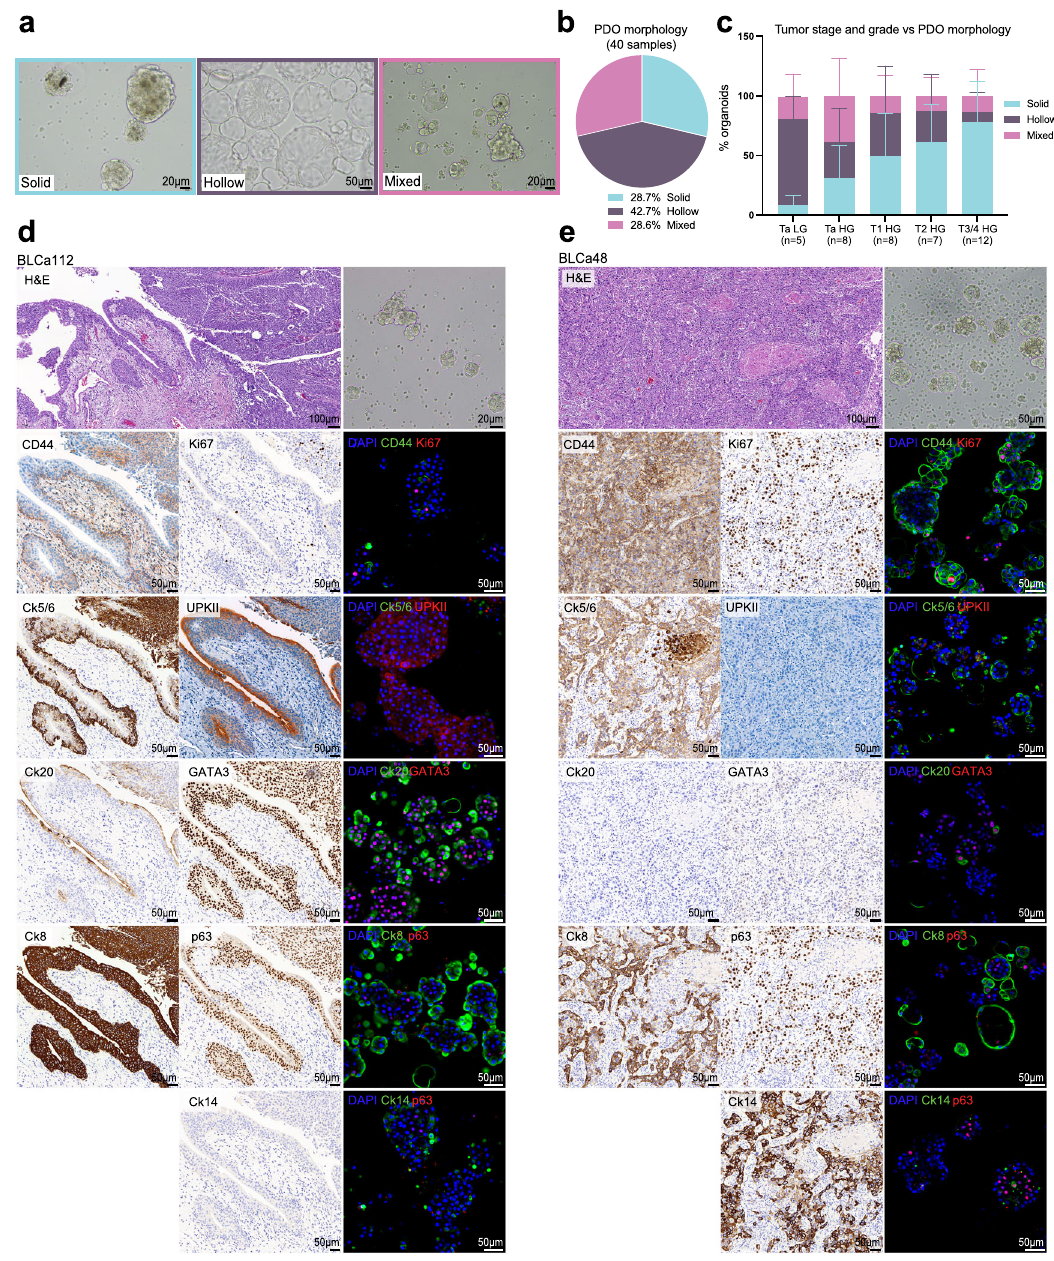
Fig. 2 | Bladder cancer (BLCa) patient-derived organoids (PDOs) recapitulate original primary tumor (PT) features in vitro. a Representative bright fi eld ima- gesofBLCaPDOsatpassage(p)1withasolid(BLCa50,day9),hollow(BLCa34,day 7), or mixed (BLCa69, day 7) morphology. b % of PDO morphology over the total analyzed samples ( n =1763 total counted organoids from 40 biological samples). c DistributionofPDOmorphologyinsamplesgroupedbasedonPTstageandgrade (mean from biological samples ± SD; n represents the number of biological sam- ples: n =5 for TaLG; n =8 for TaHGand T1HG; n =7 for T2 HG; and n =12 for T3/4 HG). Two-way ANOVA test with Tukey ’ s multiple comparison (matching values